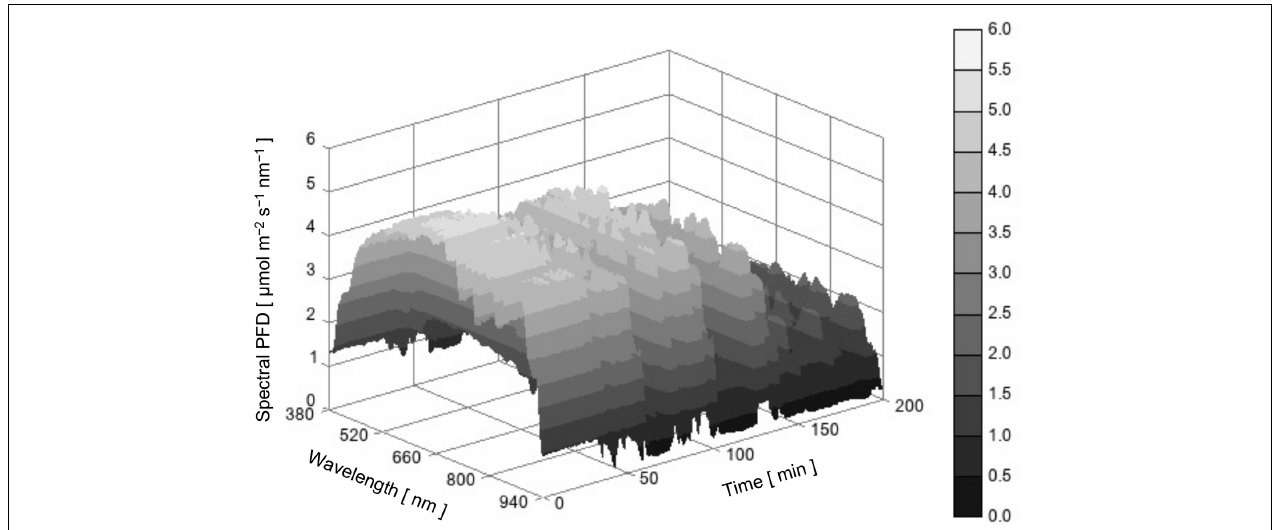
FIGURE 3 | Time course of sunlight SPD between 380 and 940 nm measured in Bunkyo, Tokyo, Japan (35 ◦ 43’N) from 11:10 to 14:30 on October 12, 2017.